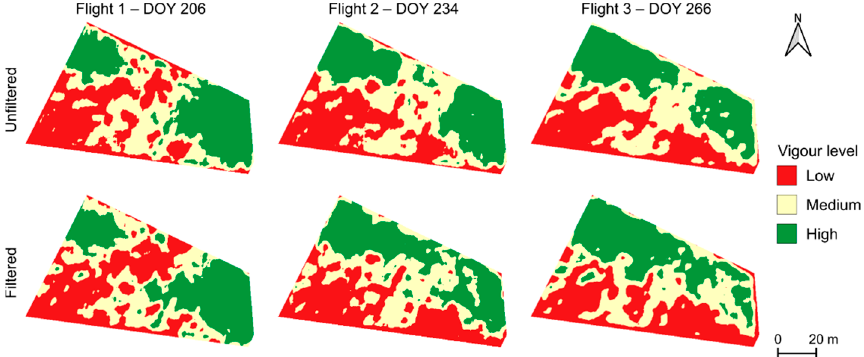
Figure 8. Vigour maps generated based on the NDVI, with three vigour levels (high, medium, and low) of the three flight campaigns, considering all of the information (unfiltered), and considering only the grapevines vegetation (filtered).